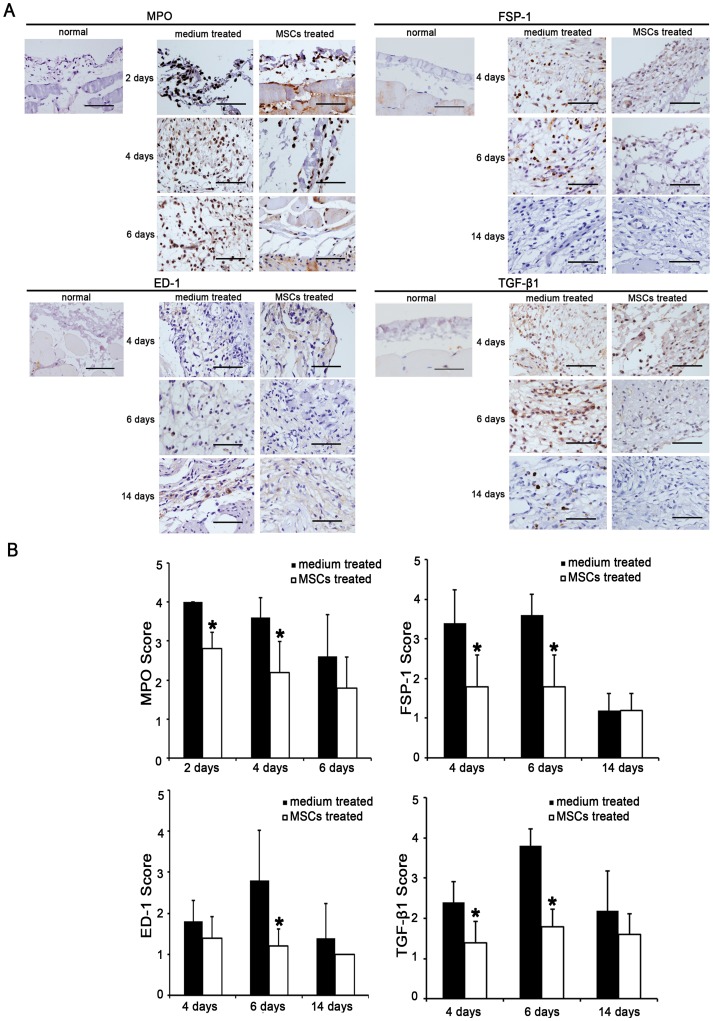
Effects of mesenchymal stem cells (MSCs) on the inflammation and fibrosis of acute peritoneal adhesions.(A). Immunohistochemical evaluation revealed that the numbers of fibroblasts (FSP-1), neutrophils (MPO), and macrophage cells (ED-1), and the level of transforming growth factor (TGF)-β1 during the active phase in acute peritoneal adhesions were decreased by injecting MSCs. Magnification  = ×400. (B). The immunohistochemical scores of MPO days 2, 4, ED-1 days 6, FSP-1 and TGF-β1 days 4, 6 after scraping were reduced by injecting MSCs. * compared with medium treated group, p <0.05, n  = 6, respectively. Sections were evaluated from five randomly selected fields under a magnification of ×100 by an independent pathologist. The extent of staining was scored as 0 (0%), 1 (1–20%), 2 (21–50%), 3 (51–80%), and 4 (81–100%), indicating the percentage of positive staining in the adhesion tissue.